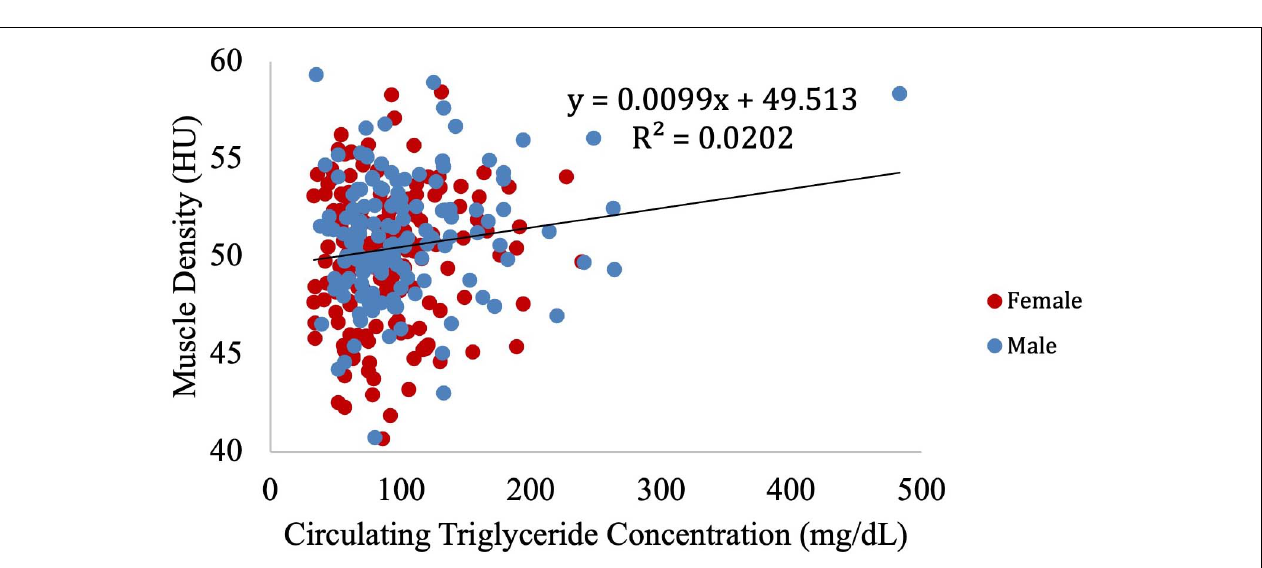
FIGURE 9 | Relationship between muscle density from CT and circulating triglyceride concentration ( p = 0.18). After adjustment for IMCL/water, the relationship between muscle density and circulating triglyceride concentration became significant ( p = 0.04). However, when the one participant with high triglyceride concentration is removed (circulating triglyceride value of 483), this correlation is no longer significant ( p = 0.12).